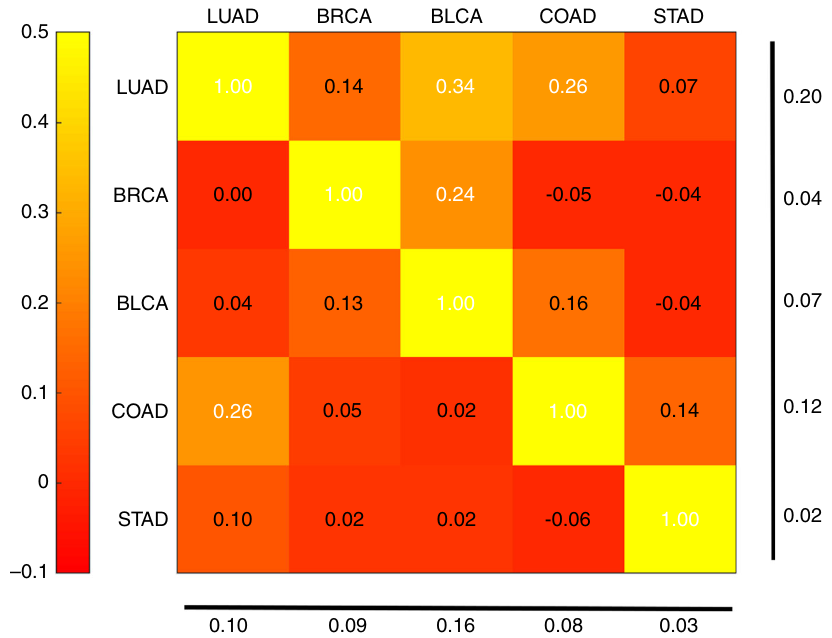
Fig. 9 Tile-level cross-classi fi cation correlations for TP53 mutational status. Row labels denote the cancer type used to train the fi rst TP53 mutation classi fi er. Column labels denote both the test tissue and the tissue of the second TP53 classi fi er. Heatmap values indicate correlation coef fi cients of mutation probability logits between the two classi fi ers on the test tissue. Numbers at the bottom and right show column and row averages, respectively, with diagonal values